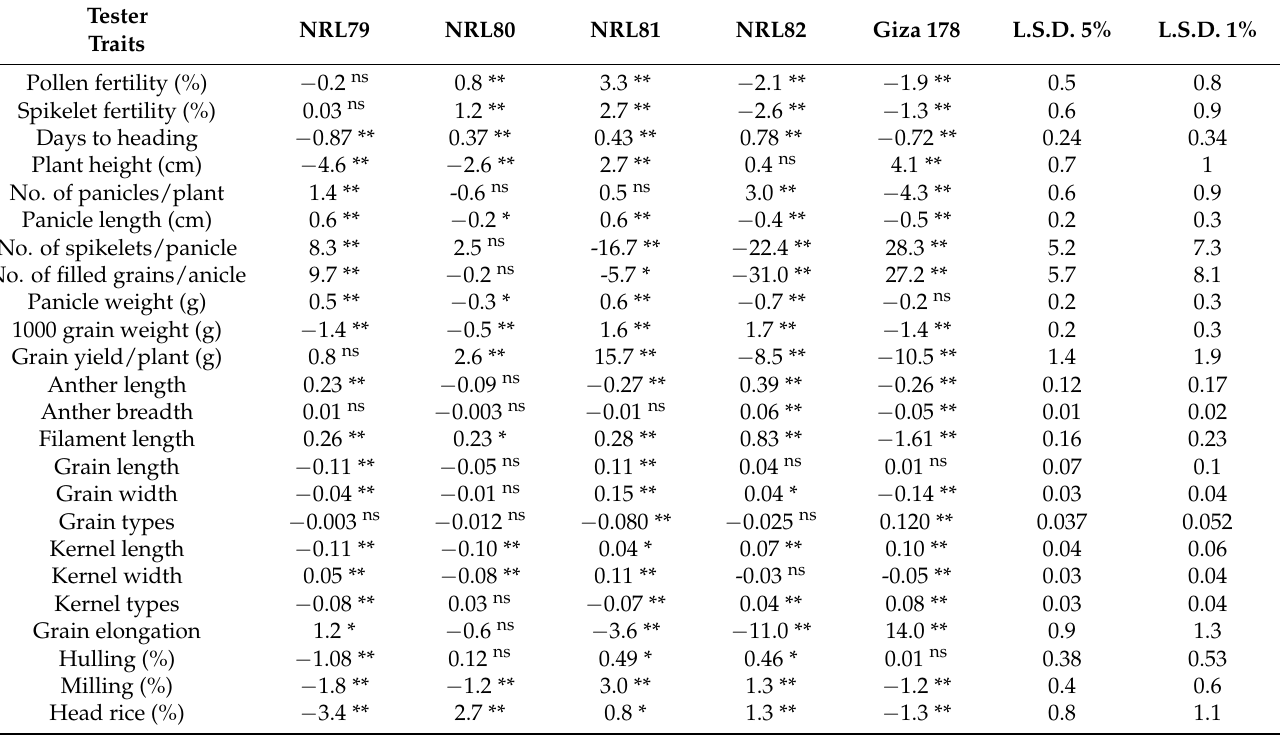
Table 5. General combining-ability effects of the tester lines for the grain yield, yield contributing traits, floral traits, and grain quality